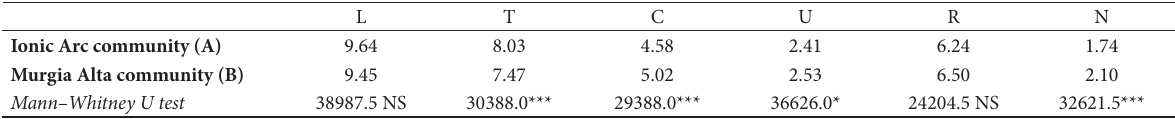
Table 3. Ellenberg's indicator values for the two groups of Satureja montana garrigues (L = light, T = temperature, C = continental-